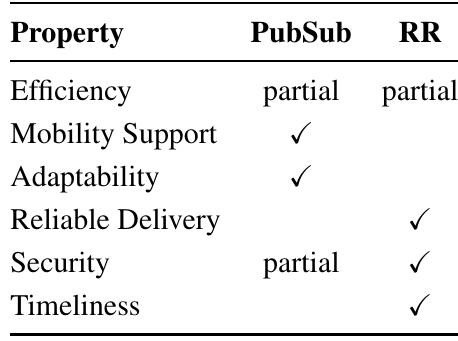
Table 1. Quality properties promoted by the PubSub and the RR